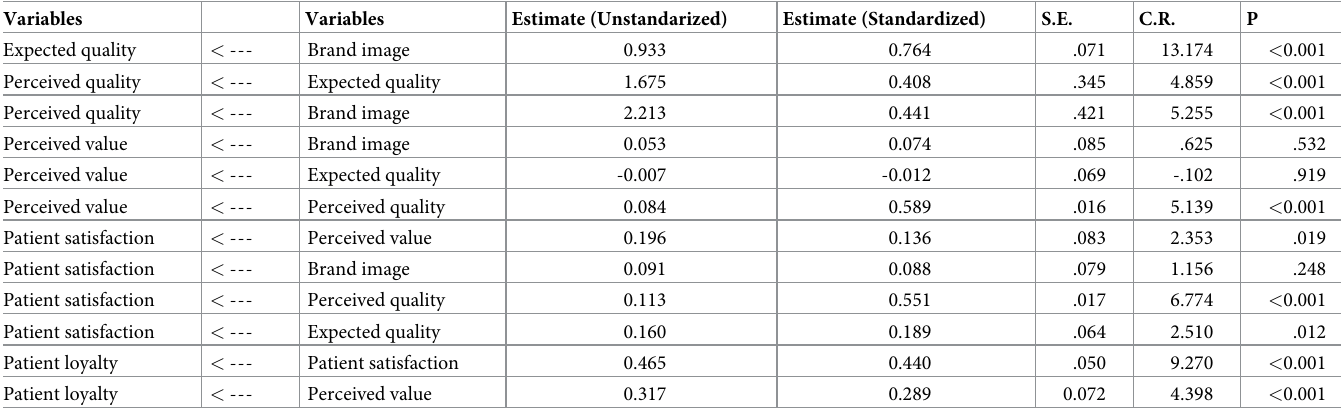
Table 4. The path coefficients in SEM (n =